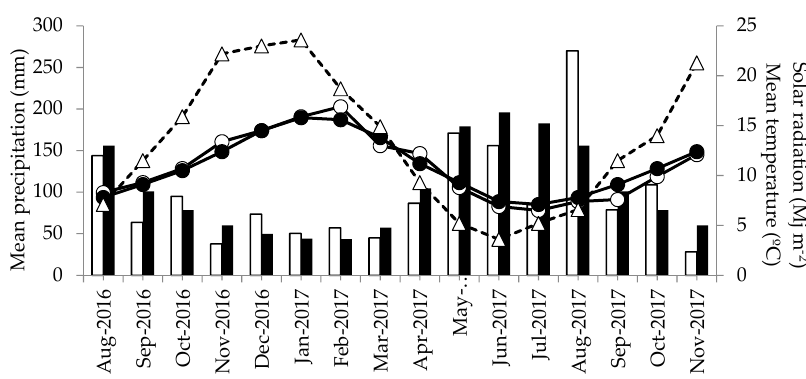
Figure 1. Observed monthly mean temperatures ( ○ ), precipitation ( □ ), and incident solar radiation ( ∆ ) during the sampling period, and historical averages (1977–2017) for mean temperature ( ● ) and precipitation ( ■ ).